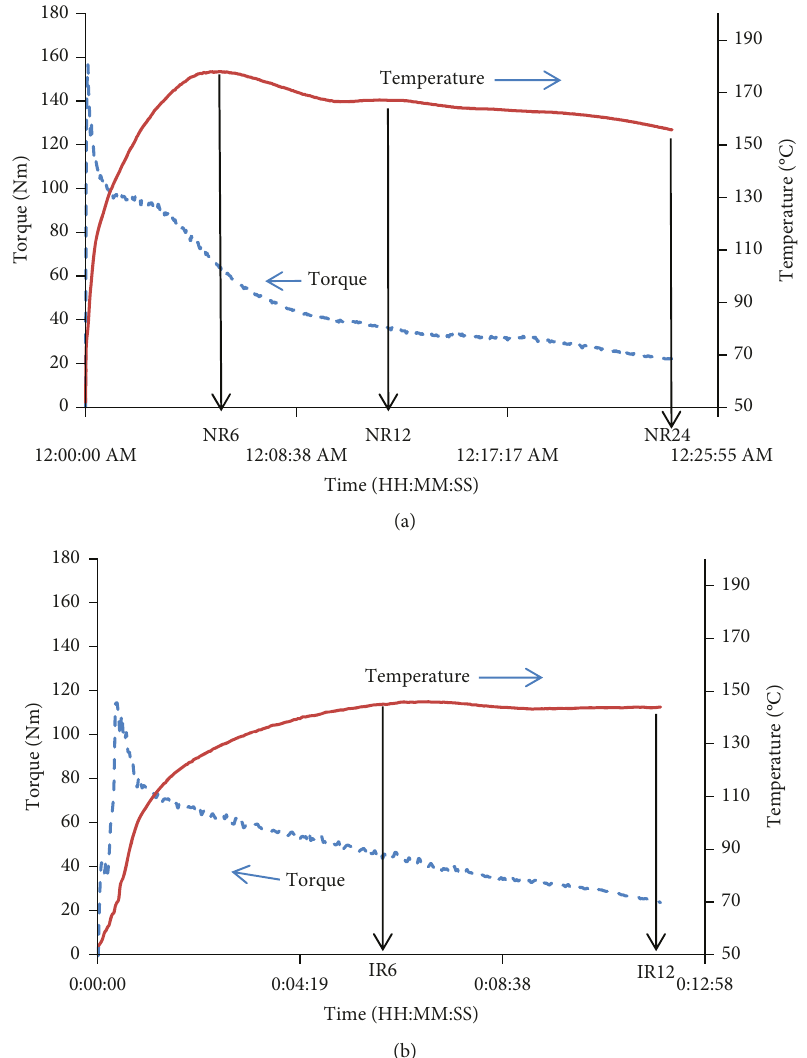
Figure 5: The plastograph of masticated NR and IR.